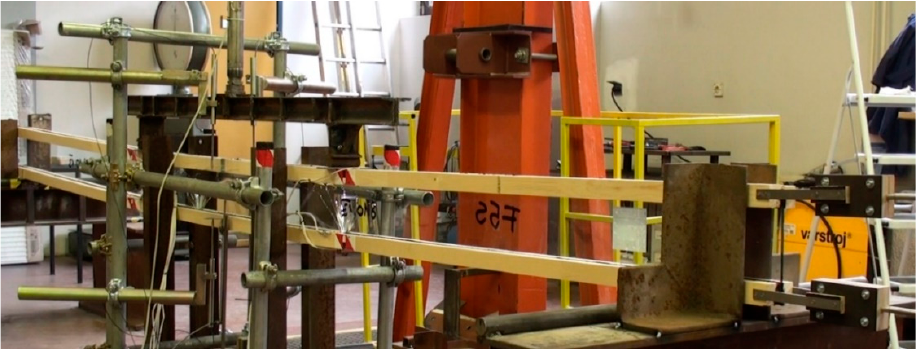
Figure 17. Positioning the specimen between the steel profiles and attaching the weight yoke.